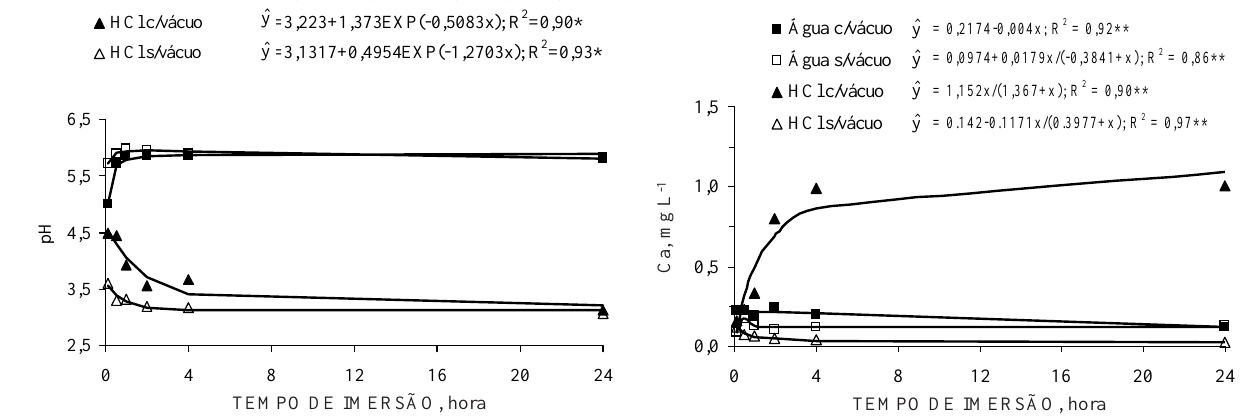
Figura 2. Teor de cálcio da água de imersão das cápsulas, considerando o tempo de